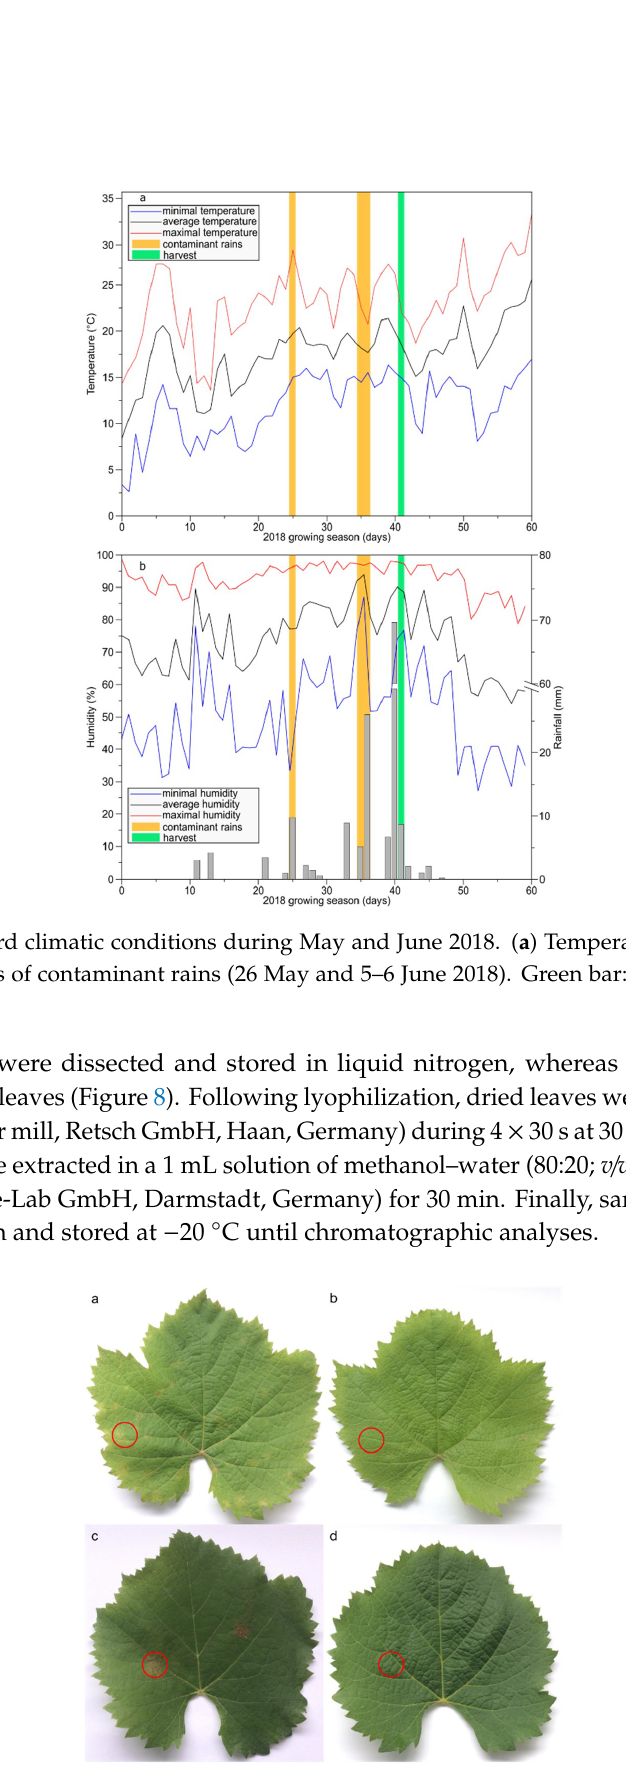
Figure 8. Leaves of Vitis vinifera L. cv. Malbec from 3rd ( a, b ) and 6th ( c, d ) positions from the apex on grape shoots. Downy mildew infected at 6 ( a ) and 15 dpi ( c ). Control ( b, d ). Circles indicate dissected zones.